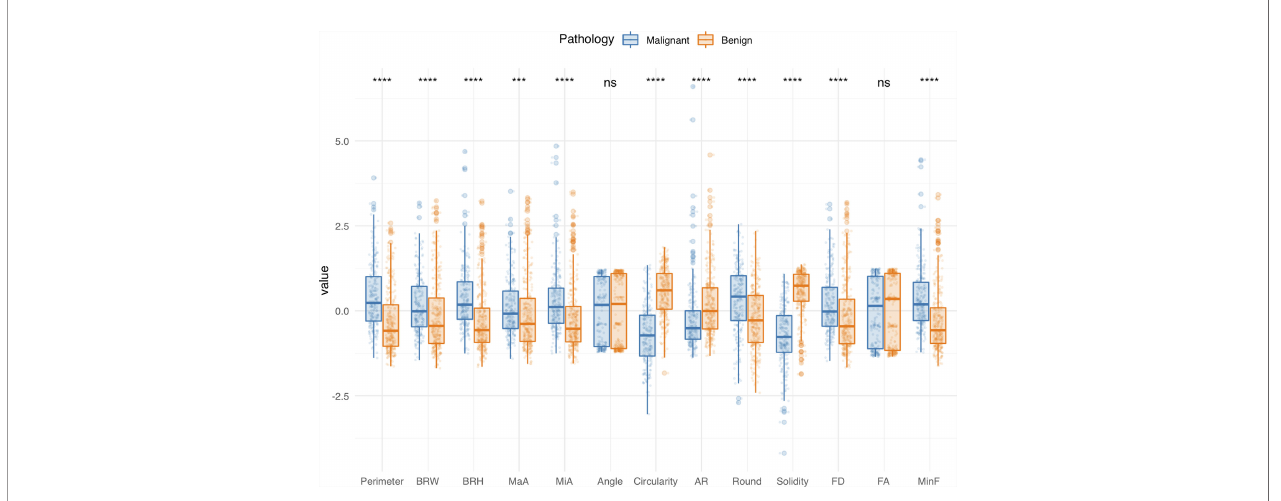
FIGURE 3 | Comparisons of morphological features between benign and malignant groups in the training cohort. Boxplots grouped by pathology show median (horizontal bars), IQR (boxes), and 95% CI (whiskers). Raw data points for each group are shown at the bottom of each box plot. Data were normalized and centered by Z-score transformation to appear on the same scale. Statistical analysis was performed using the Wilcoxon rank-sum test (all features except Round) and Student ’ s t test (Round). *** p < 0.001, **** p < 0.0001, ns, not signi fi